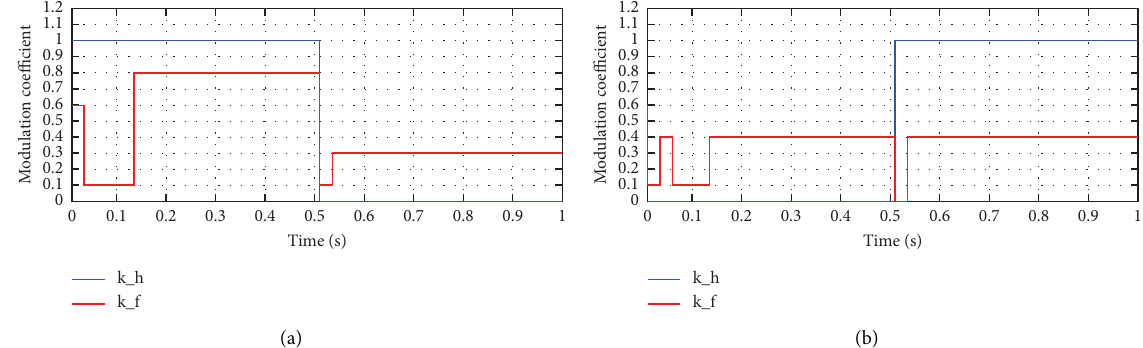
Figure 19: Modulation coefcients of reference currents of the grid-connected inverter of the PV system (a) and wind generator (b). –0.200.20.40.60.811.2 –0.4 –1.2–1–0.8–0.6 Figure 20: Modulation coefcients of reference.